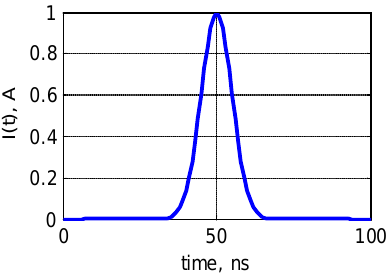
Figure 15: Time variation of the excitation signal.